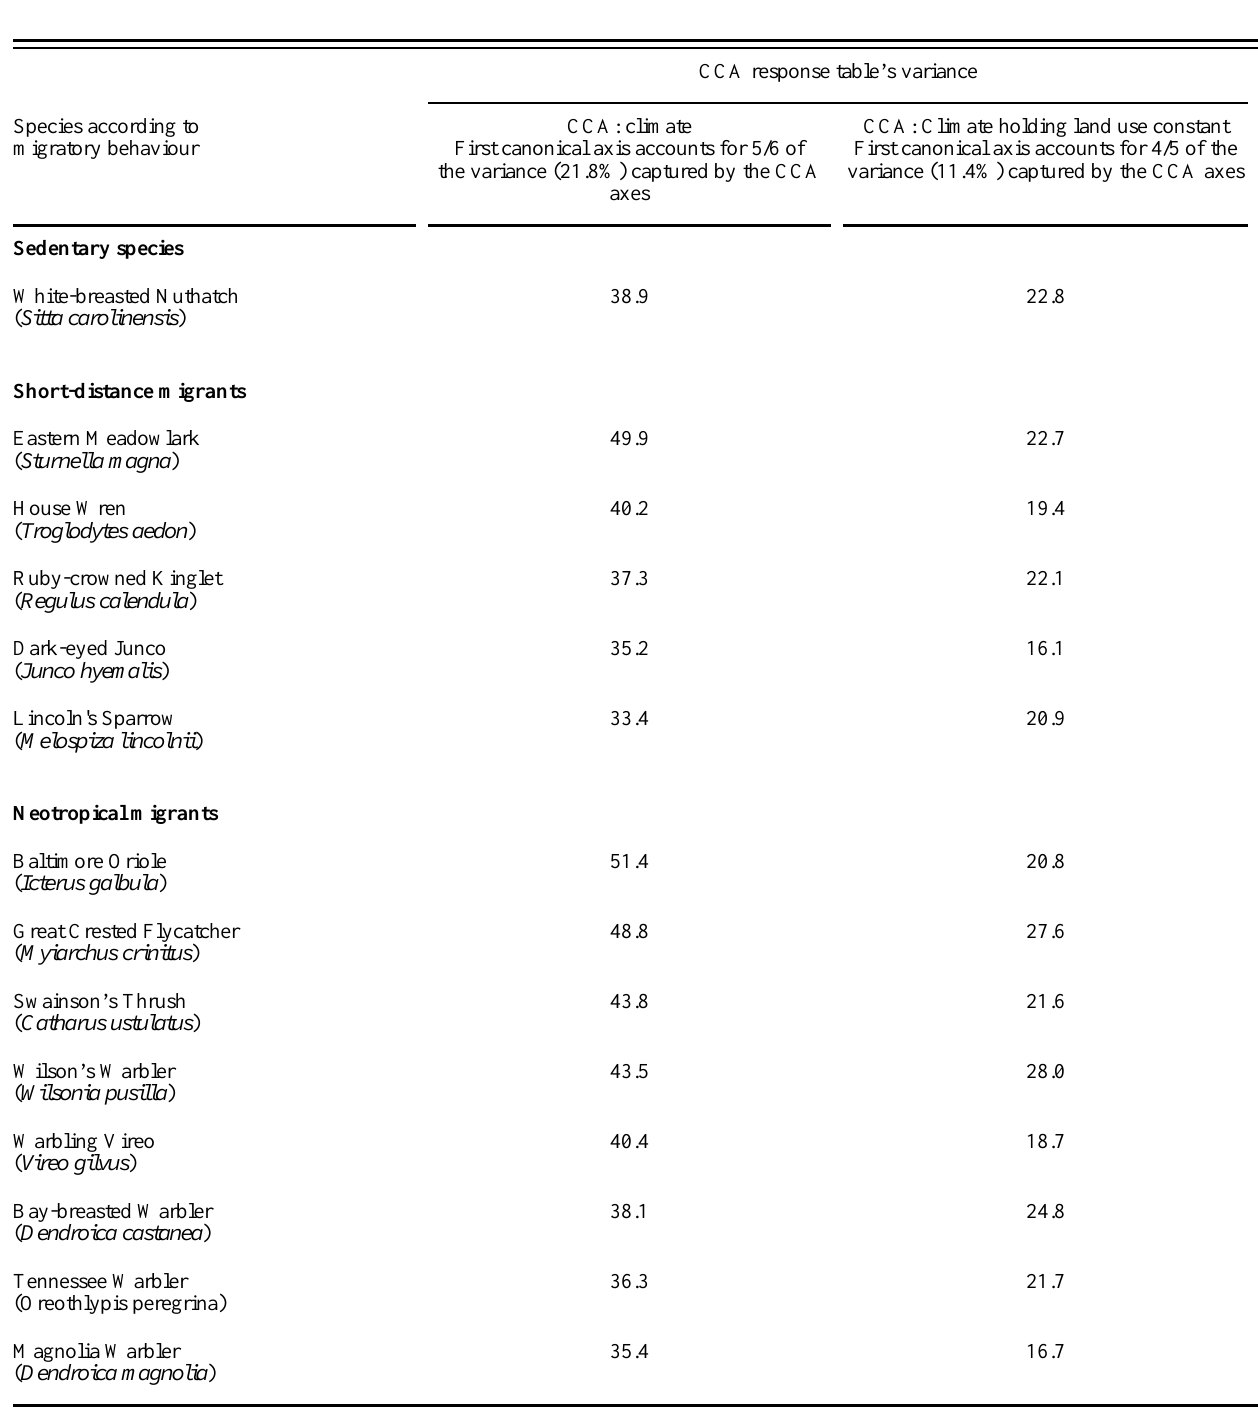
Table 6. Species of breeding birds with the highest percentage of variance in distribution explained by climatic variables, based on results for Axis 1 of two Canonical Correspondence Analyses (CCA), according to migration